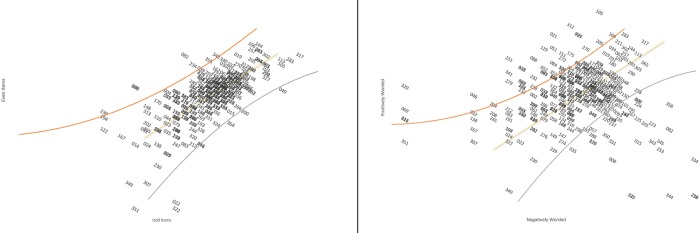
Scatterplot of the persons estimates after the division of the items into even and odd (left) and positively worded and negatively worded items (right). The de-identified numbers indicate the study participants. The x-axis and y-axis indicate the participants’ latent trait estimated from a different subset of items (e.g. in the picture on the left, the x-axis displays the participants’ latent trait according to their responses to odd-numbered items and the y-axis displays the participants’ latent trait according to their responses to even-numbered items). The yellow line is the identity line and the confidence bands are the 95% C.I.